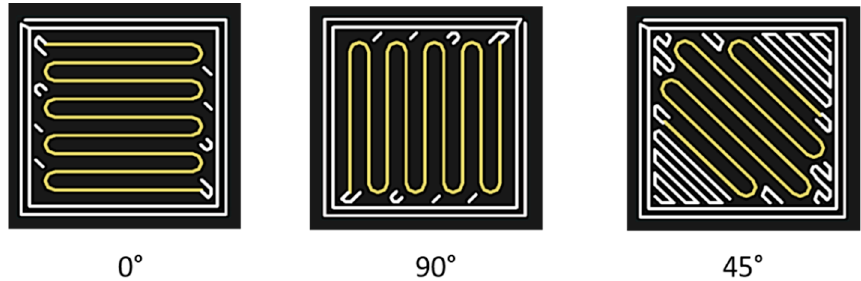
Figure 2. Orientation of reinforced continuous carbon fiber in wear specimen.